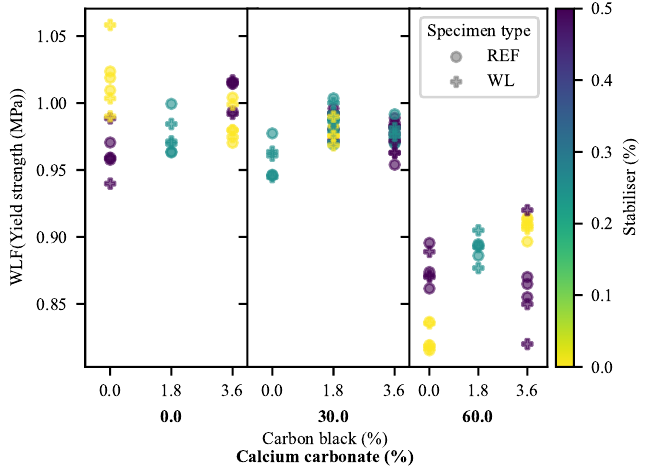
Figure 7. WLF( σ Y ) as a function of the loadings of calcium carbonate, carbon black and the stabiliser package. Specific attention must be paid to the step down to the 60-CC level and the curvature of the trends as a function of